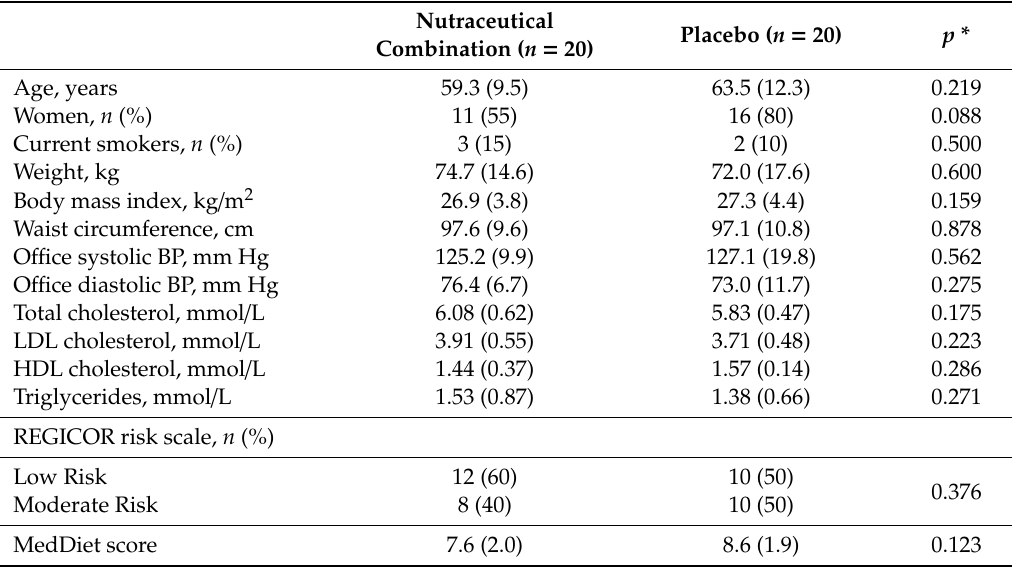
Table 1. Baseline characteristics of the participants by study